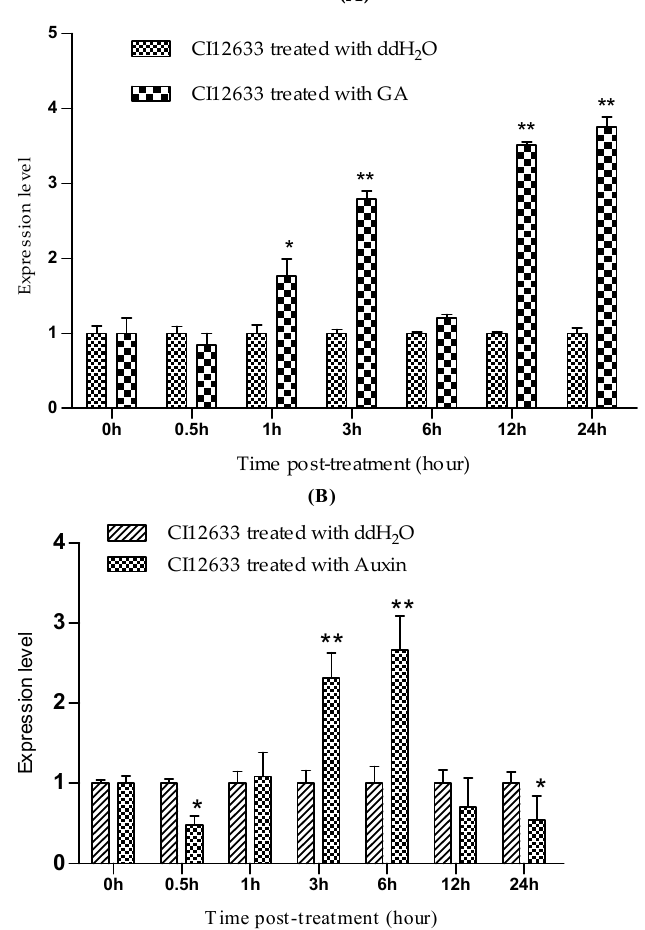
Figure 6. Expression trends of TaLecRK-IV.1 in CI12633 wheat plants treated with exogenous GA ( A ) and Auxin ( B ). Plants treated with sterile ddH 2 O were considered as control. The relative gene expression was quantified using the comparative 2 −∆∆ CT method, and TaActin was used as the reference gene to normalize the expression level of TaLecRK-IV.1 . The Student’s t -test was used to compare the expression data and asterisks indicate significant expression difference at 0.05 (*) or 0.01 (**) probability level.